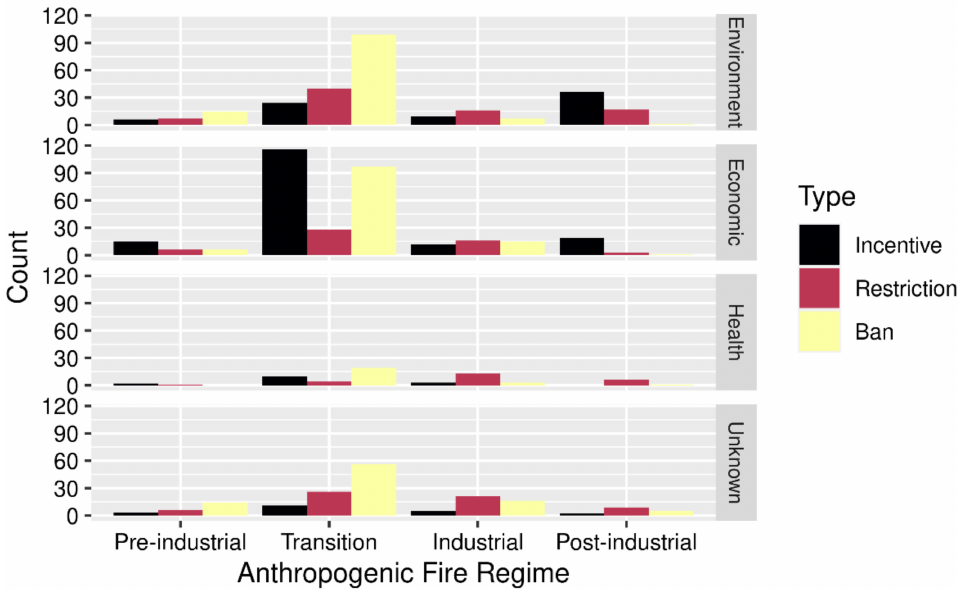
Figure 5. Fire Policy by Anthropogenic Fire Regime. Counts are of case studies including a given fire policy type. Policy rationales are described in Section